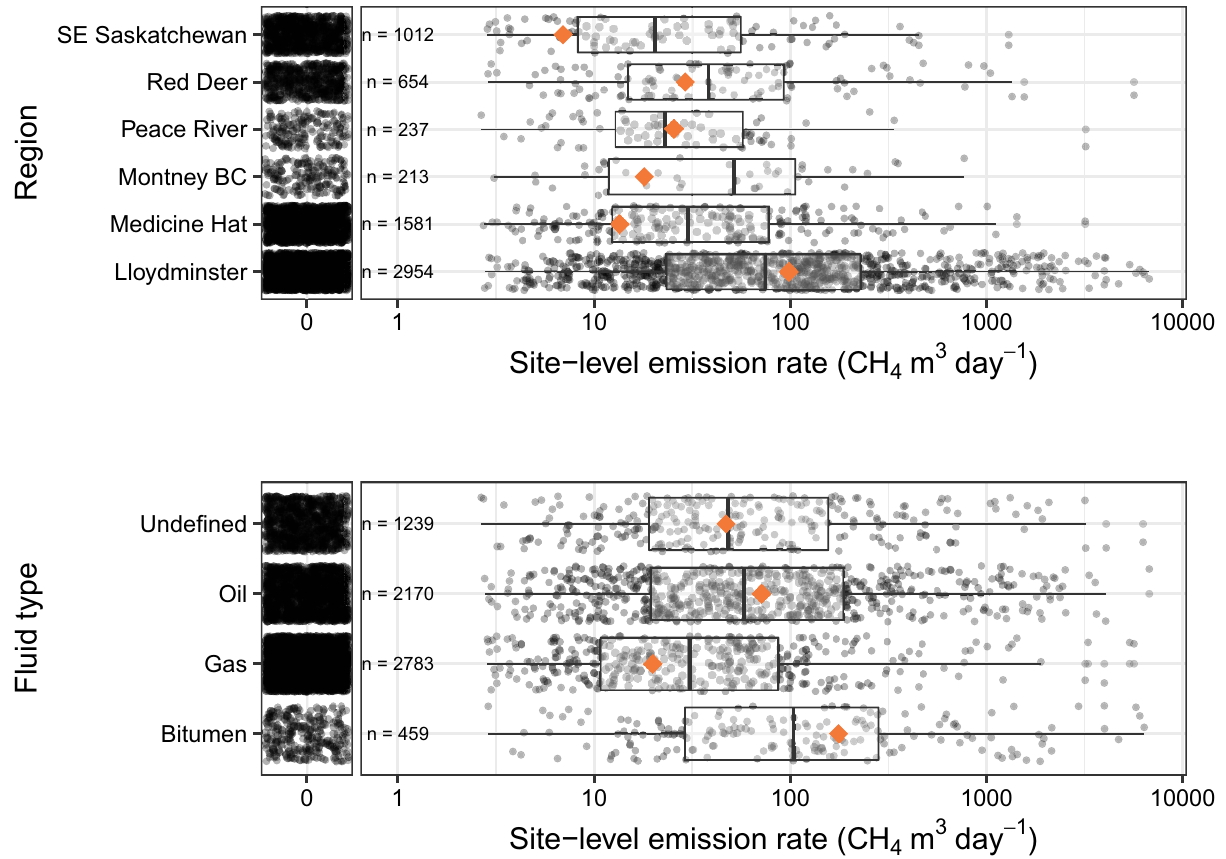
Figure 1. Distributions of measured emission rates (logarithmic scale) by region (top) and by fluid type (bottom). Black dots represent individual site-level emission rates. For better visualization of the emission rate distributions, the plots are broken down to show non-emitting sites (left panel, emission rate = 0), and emitting sites (right panels). The box limits are the interquartile ranges (IQR), and whiskers represent the upper (Q3 + 1.5 * IQR) and lower (Q1 − 1.5 * IQR) ranges of non-zero emissions. The orange diamond is the overall mean (emitting and non-emitting) for each